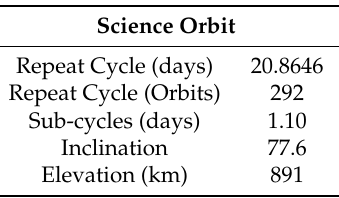
Table 1. Orbital characteristics of the Science Orbit implemented in the Surface Water and Ocean Topography (SWOT) simulator and used in the present experiments.